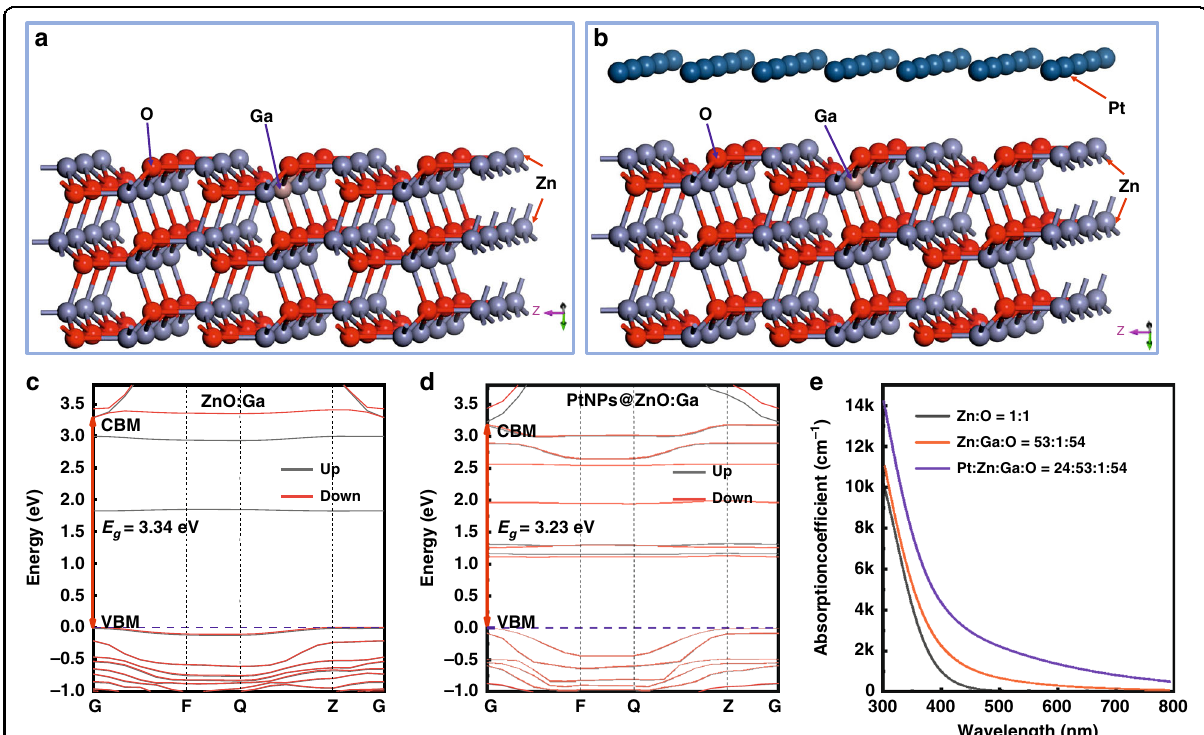
Fig. 6 Theoretical analysis and calculation on the superabsorption characteristics of the large-size PtNPs. a Supercell structure of ZnO:Ga. b Structures of the PtNPs@ZnO:Ga interface: Zn termination (left) and O termination (right). c Band structure under spin polarization of ZnO:Ga system. d Band structure under spin polarization of ZnO:Ga covered by PtNPs. e Calculated optical absorption curves for ZnO, ZnO:Ga, and